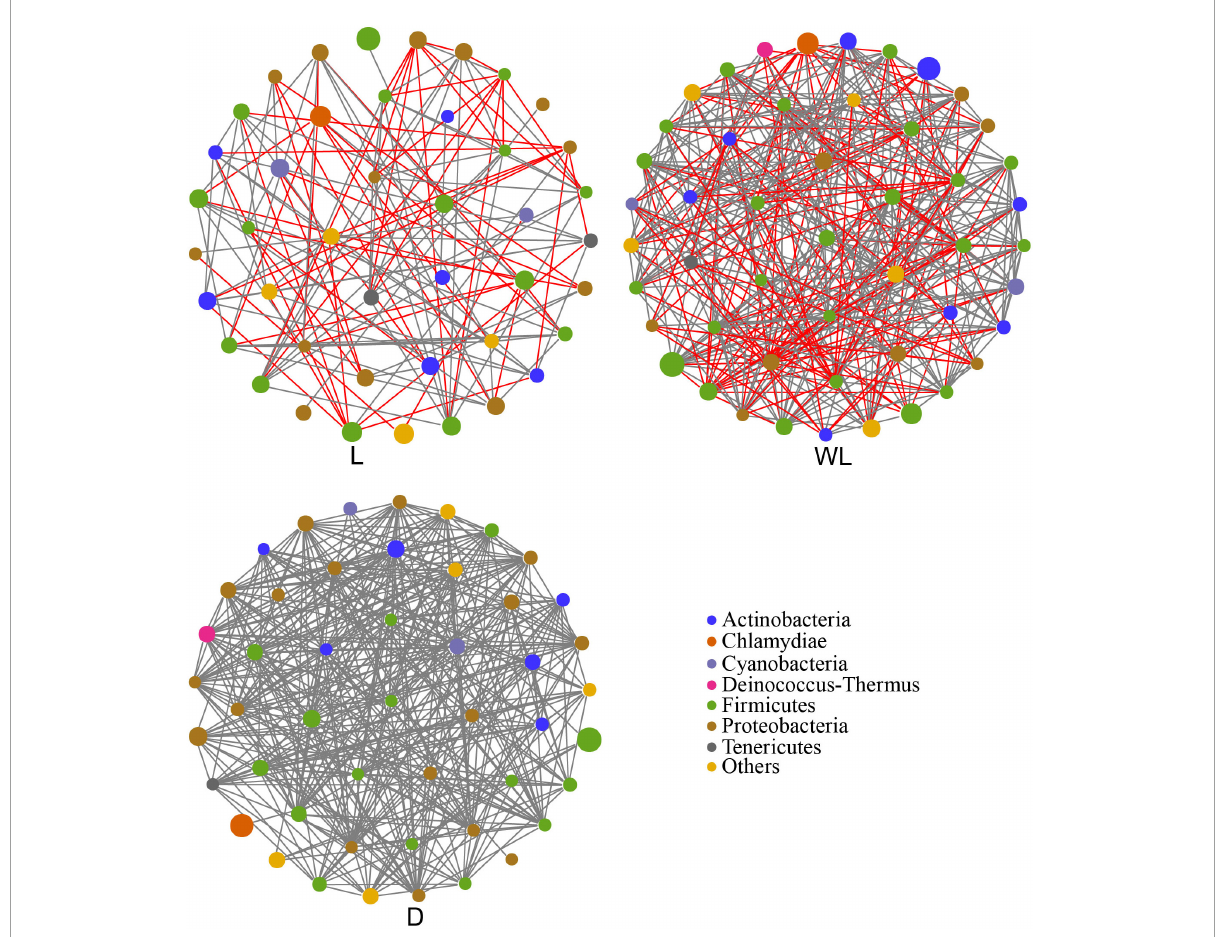
FIGURE3 Co-occurrence network analysis of gut bacteria community in D. japanica . The size of the node represents the relative abundance. Positive interaction, gray line; negative interaction, red line.